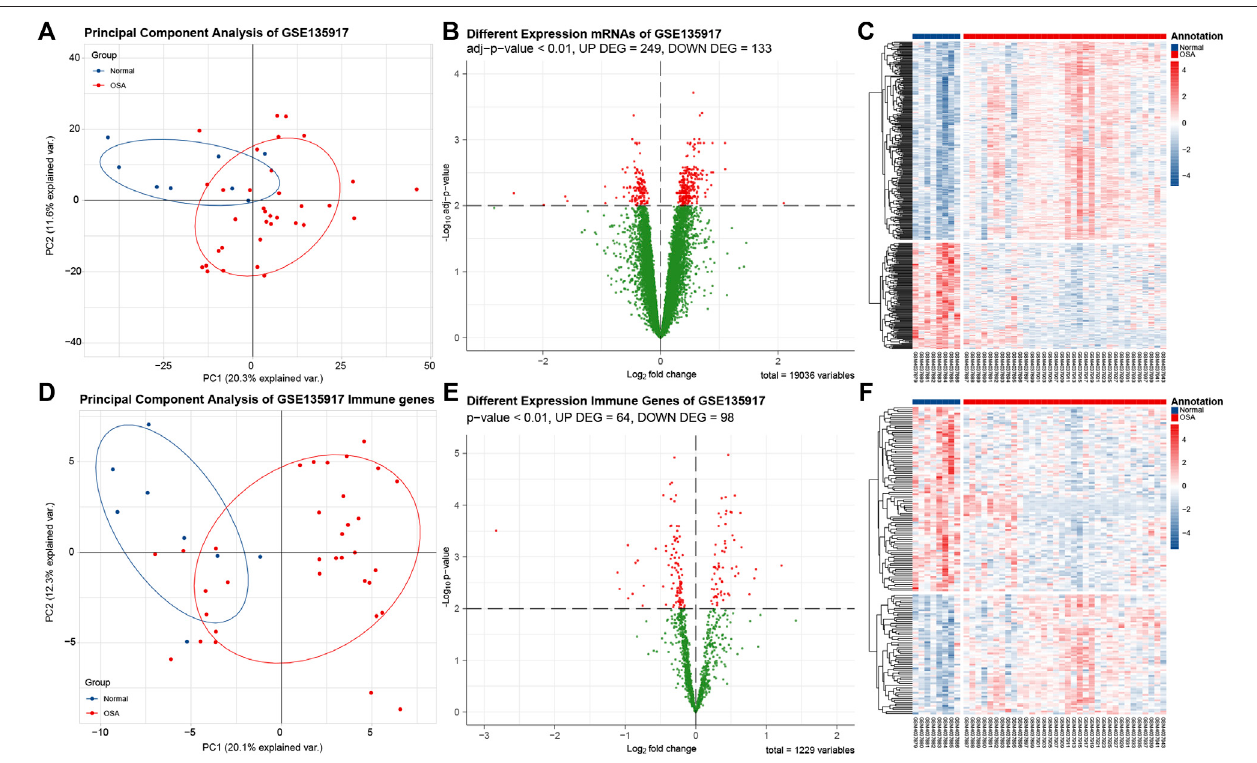
FIGURE3| AnalysisofDEGsandimmune-relatedDEGsindatasetGSE135917. (A) Principlecomponentanalysis(PCA)plotof382DEGsshowsthatsamplesbe divided into two clusters. Blue dots indicate normal samples, red dots indicates obstructive sleep apnea (OSA) samples. (B) The volcano plot of differentially expressed genes (DEGs). Red dots represent signi fi cant different expression genes, and green dots represent no signi fi cant different expression genes. (C) The heatmap ofDEGs. Each row represents one gene, and each column represents one sample. Red indicates that the expression of genes is relatively upregulated, and blue indicates that the expression of genes is relatively downregulated. (D) . PCA plot of 162 immune-related DEGs. (E) The volcano plot of immune-related DEGs. (F) The heatmap of immune-related DEGs.